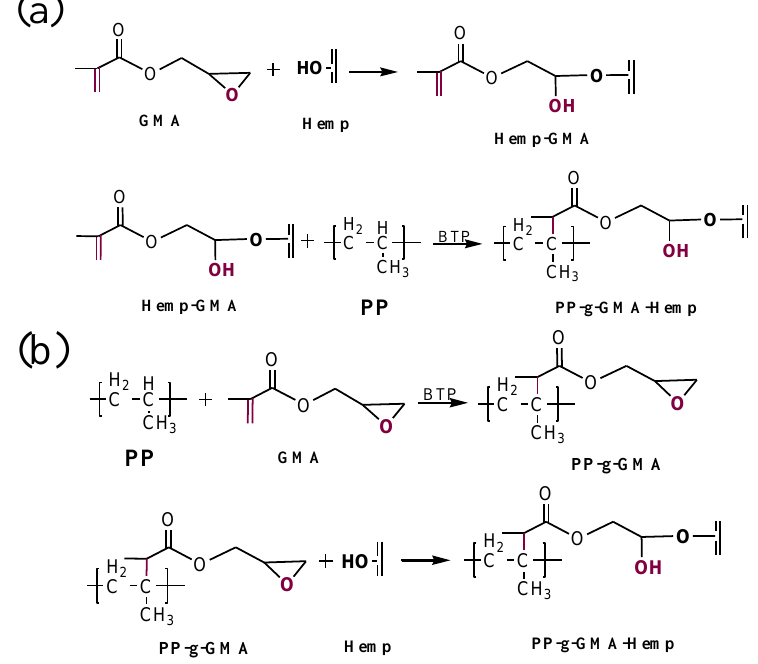
Figure 2 . Scheme of (a) hemp modification with GMA and grafting onto PP, (b) grafting of GMA onto PP and reaction with